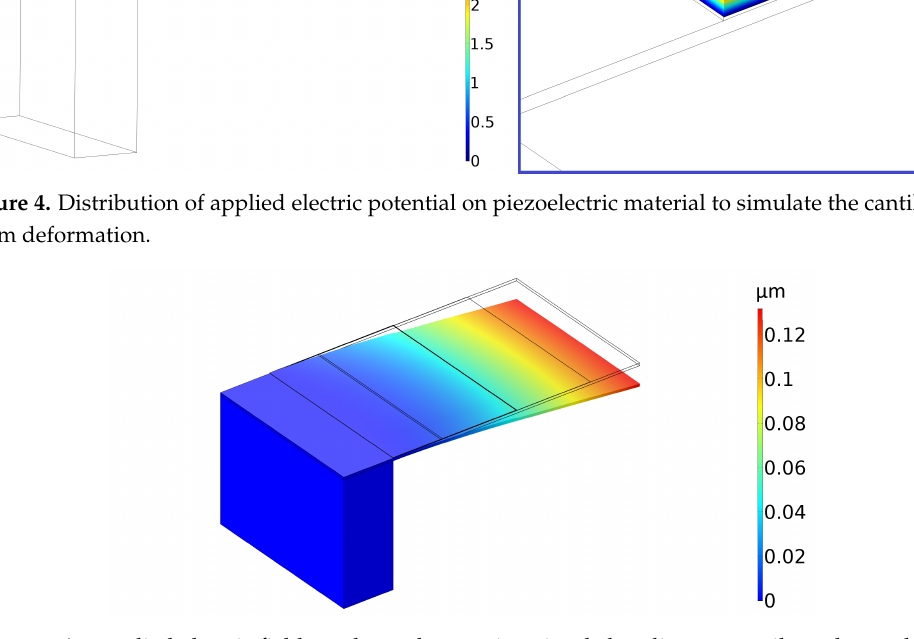
Figure 5. An applied electric field on electrodes causing simple bending on cantilever beam due to piezoelectric effect to compare with cantilever beam resonance frequency mode shapes.